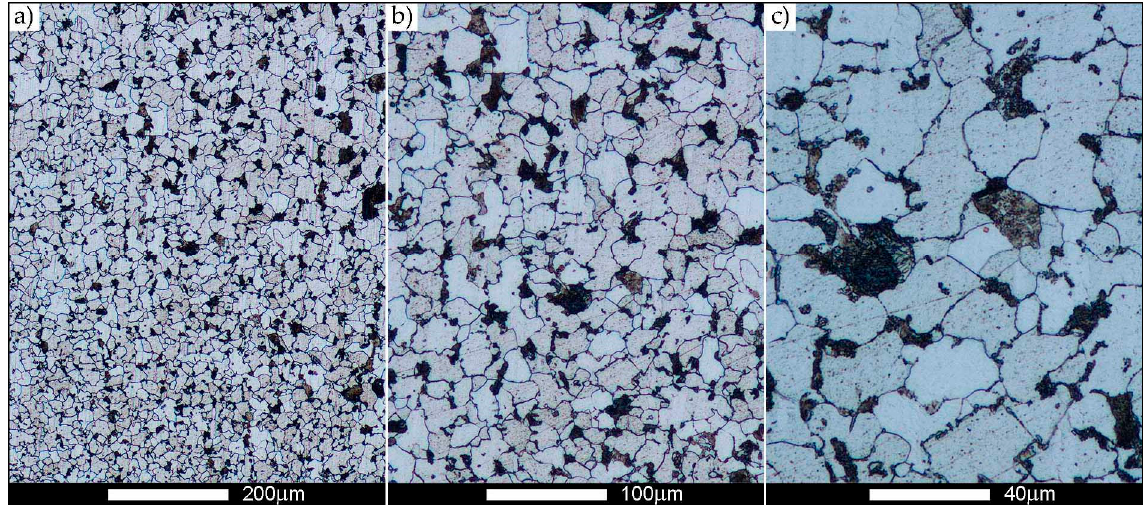
Figure 59. Welded joint microstructure of Hardox 450 steel with visible prior austenite grain boundaries, austenitised at 900 °C—HAZ zone. ( a ) 100×; ( b ) 200×; ( c ) 500×.